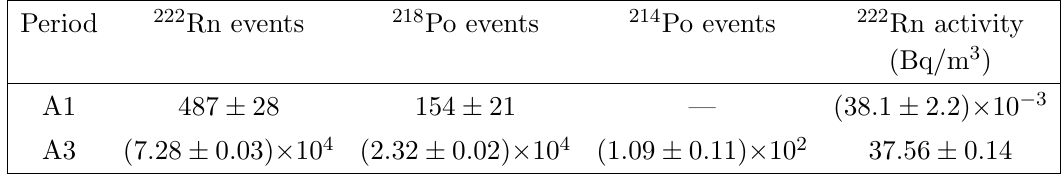
Table 2 . Fitted yields and speci(cid:12)c 222 Rn activity in the (cid:12)ducial volume of NEXT-White, during run periods A1 and